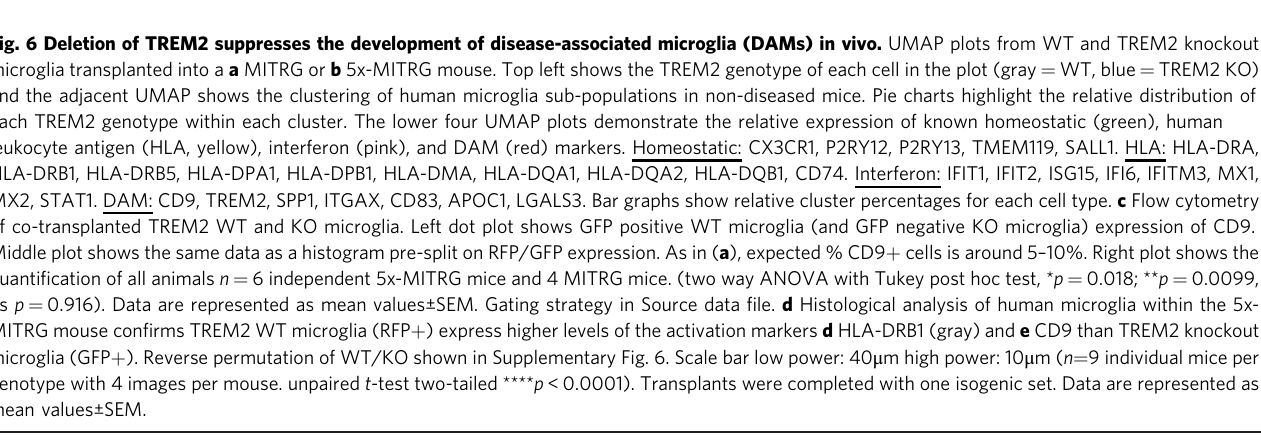
Fig. 6 Deletion of TREM2 suppresses the development of disease-associated microglia (DAMs) in vivo. UMAP plots from WT and TREM2 knockout microglia transplanted into a a MITRG or b 5x-MITRG mouse. Top left shows the TREM2 genotype of each cell in the plot (gray = WT, blue = TREM2 KO) and the adjacent UMAP shows the clustering of human microglia sub-populations in non-diseased mice. Pie charts highlight the relative distribution of each TREM2 genotype within each cluster. The lower four UMAP plots demonstrate the relative expression of known homeostatic (green), human leukocyte antigen (HLA, yellow), interferon (pink), and DAM (red) markers. Homeostatic: CX3CR1, P2RY12, P2RY13, TMEM119, SALL1. HLA: